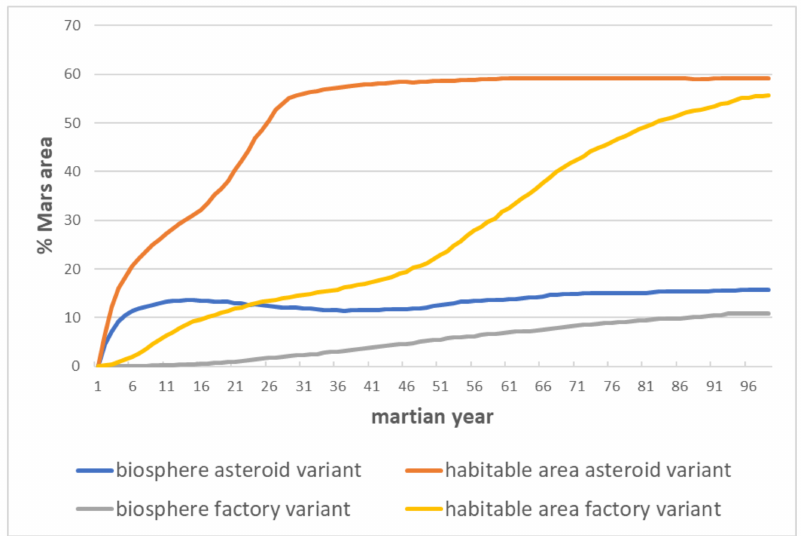
Figure 18. Percentage of Mars area with an average temperature above − 25 ◦ C (habitable area) and above 0 ◦ C